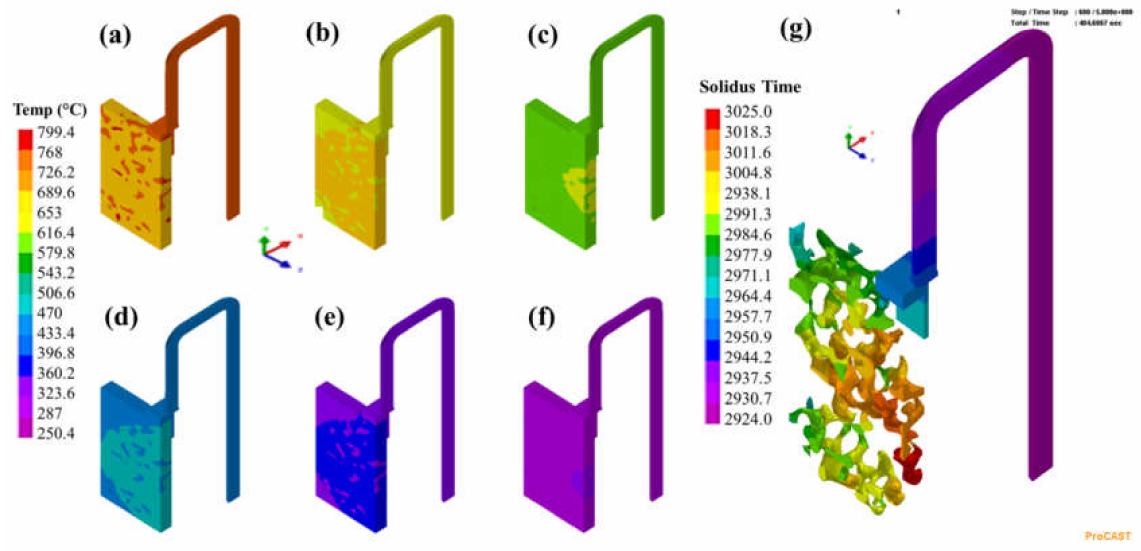
Figure 5. Temperature distribution of SiC/Al composite during pressure infiltration cooling: ( a ) 1.1 s; ( b ) 1626.0 s; ( c ) 2276.0 s; ( d ) 7346.0 s; ( e ) 8516.0 s; ( f ) 8906.0 s. ( g ) Cloud chart of setting